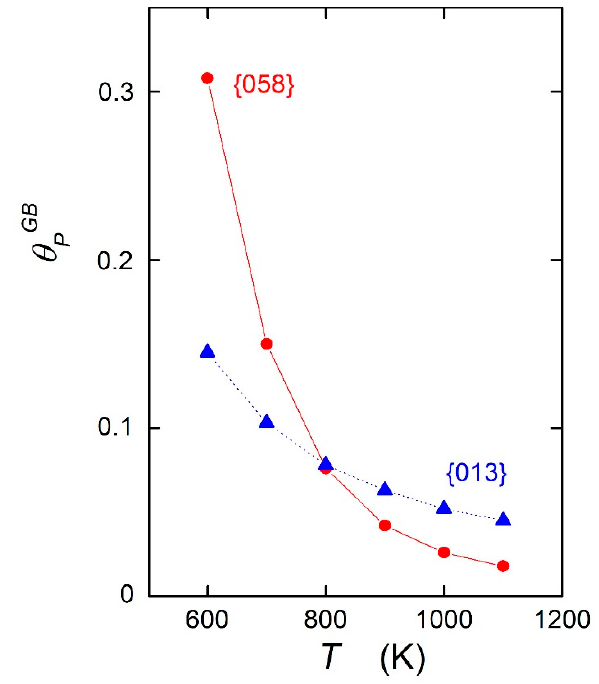
Figure 4. Temperature dependence of the phosphorus concentration at the {013} grain boundary (triangles) and at the {058} grain boundary (circles) calculated according to Equation (1). Data are from Reference [14].